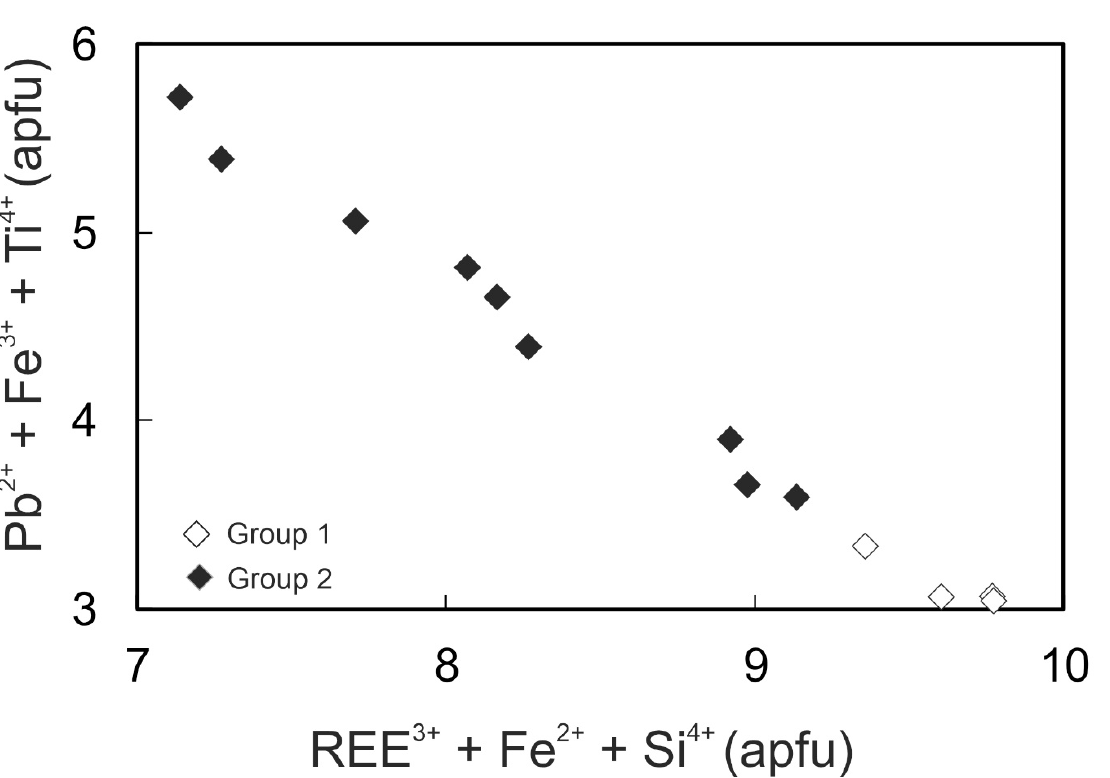
Figure 8. Possible substitution scheme for Pb ‐ rich, partly altered, Group 2 chevkinite ‐ (Ce).